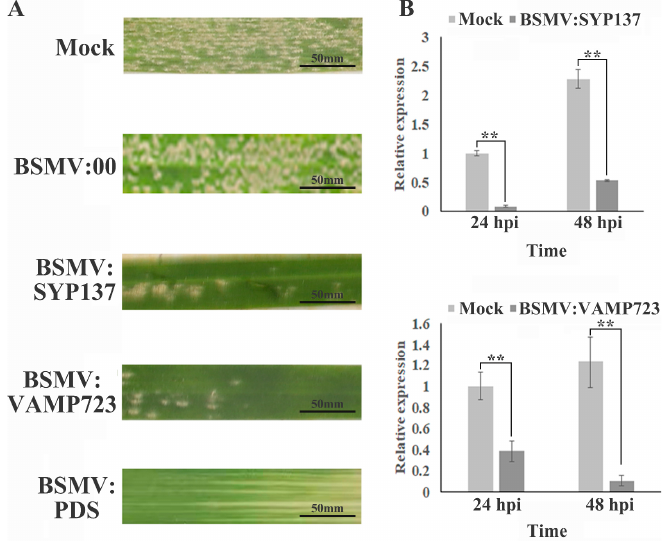
Figure 5. Effect of TaSYP137 and TaVAMP723 silencing on the response of N9134S leaves to Bgt stress. ( A ): Images showing the appearance of the silenced phenotype 7 days after inoculation with BSMV-PDS; the effect of the reconstructed vectors BSMV-TaSYP137 and BSMV-TaVAMP723 on in- oculated leaves of N9134S leaves after Bgt infection; and the mock and BSMV-Blank groups treated with buffer in the same way. ( B ): Relative expression level of TaSYP137 and TaVAMP723 . Data were the mean of three biological replicates ± S.E. Asterisks denote significant differences by Student’s t - test analysis ( t -tests, ** p < 0.01). 2.4. TaSYP137 Interacted with the TaVAMP723 Protein According to previous reports, SNARE proteins form complexes to perform specific functions. In addition, SYP137 and VAMP723 can interact with each other in response to pathogenic bacteria in many other species. In this study, evidence of the interaction be- tween TaSYP137 and TaVAMP723 was provided using the yeast two-hybrid system. We cloned TaVAMP723 and TaSYP137 genes into pGBKT7 and pGADT7 yeast vectors, re- spectively, with pGBKT7 containing the DNA-binding domain (BD) and pGADT7 con- taining the activation domain (AD). Positive control plasmids, pGBKT7-53 and pGADT7- T, and negative control plasmids, pGBKT7-lam and pGADT7-T, were used. For the exper- imental groups, pGBKT7-VAMP723 and pGADT7-SYP137 were designated as group 1, while pGBKT7-SYP137 and pGADT7-VAMP723 were designated as group 2. The yeast receptor state was transformed and then spotted on SD/-Leu-Trp to screen the